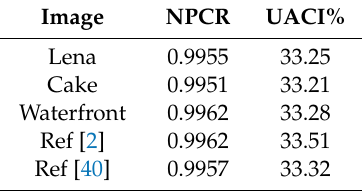
Table 1. NPCR and